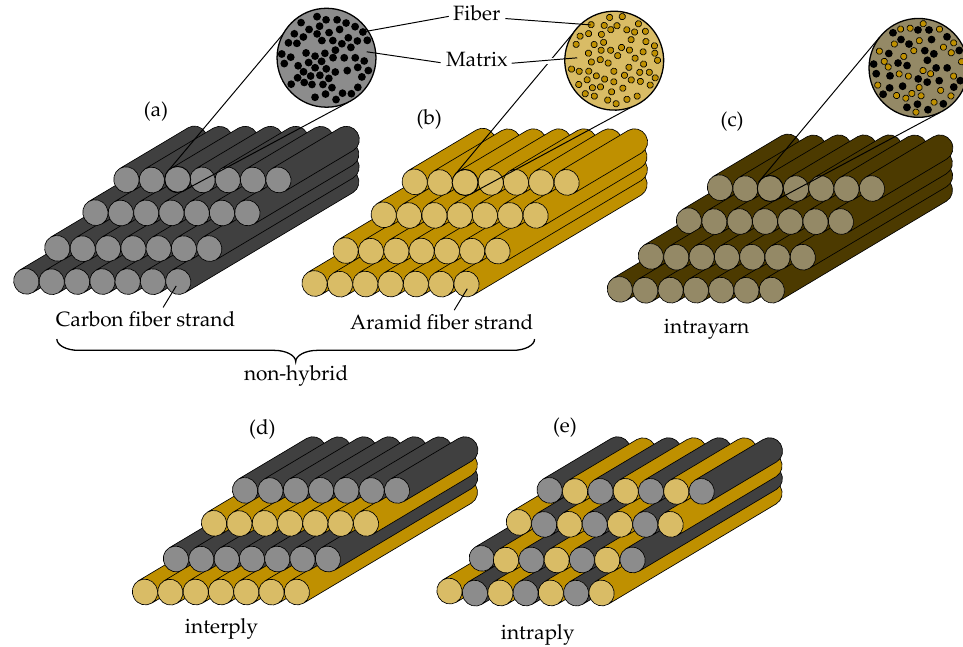
Figure 2. Approaches to hybridization in the context of continuous fiber-reinforced MEX: ( a ) non- hybrid composites with carbon fibers; ( b ) non-hybrid composites with aramid fibers; ( c ) combined fiber materials within a fiber strand (intrayarn); ( d ) layer-by-layer hybridization (interply); ( e ) strand- by-strand hybridization